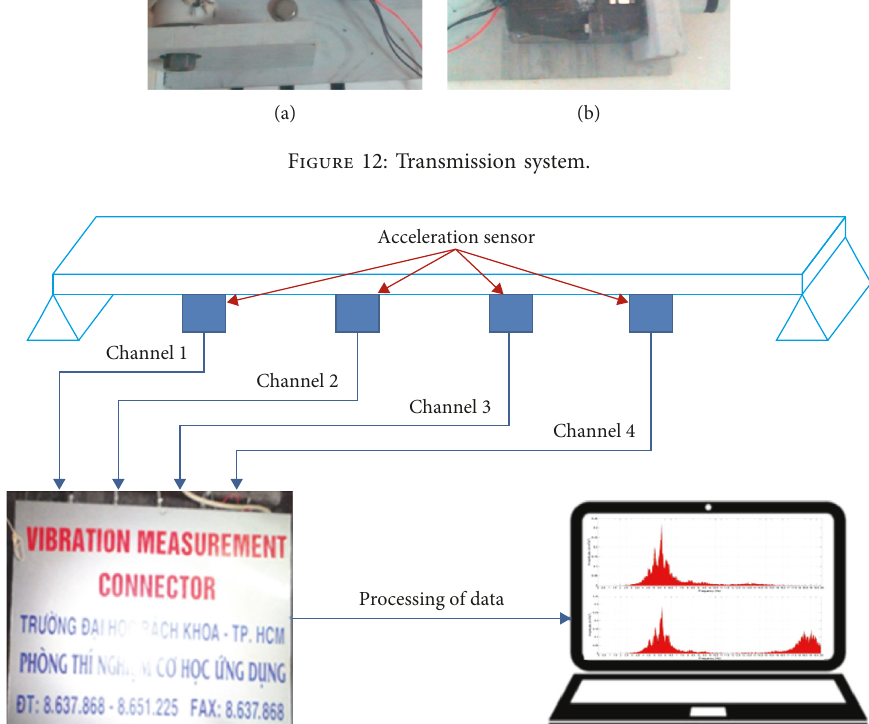
Figure 13: The signal received from the acceleration sensor. Table 1: Number of the vibration period.